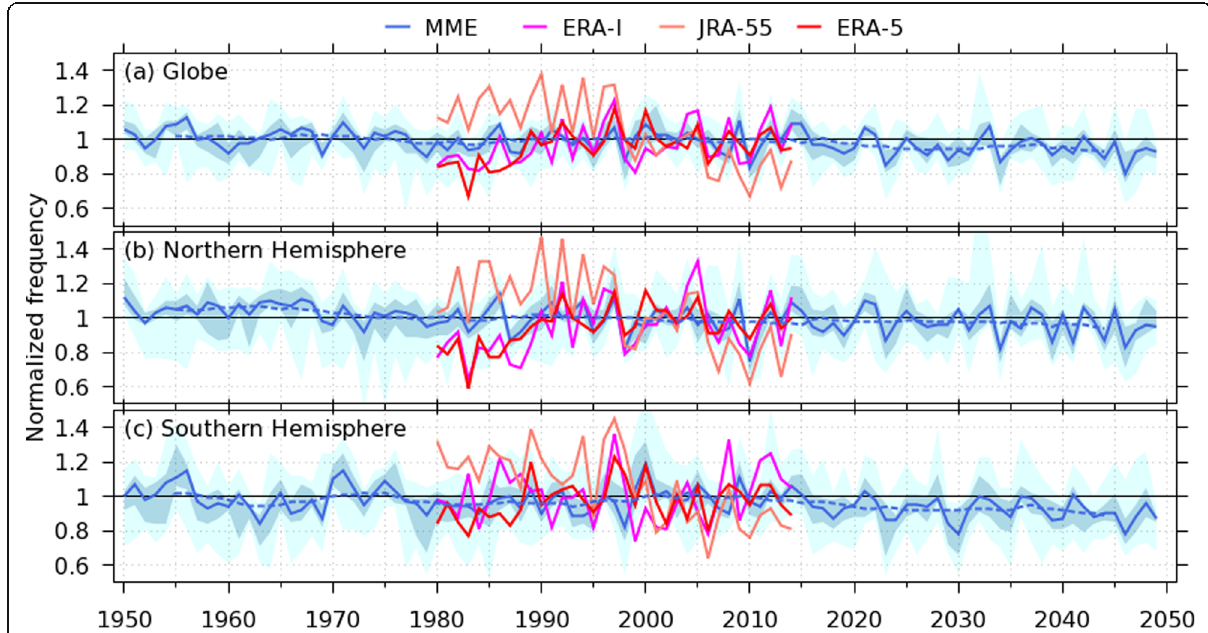
Fig. 4 Time series of normalized annual TC seed frequency. Annual TC seed frequency was normalized based on the mean value from 1990 to 2014 for respective data. Panels show time series of normalized annual TC genesis frequency for a the globe, b the Northern Hemisphere, and c the Southern Hemisphere, respectively. Blue solid line shows the median value of models without NCM014. Blue dotted line shows eleven years running mean of the median value. Light blue colored area indicates a range between 5 and 95 percentile values of models. Deep blue colored area indicates a range between 25 and 75 percentile values of models. Magenta line is a result from ERA-I. Orange line indicates JRA-55. Red line indicates ERA-5